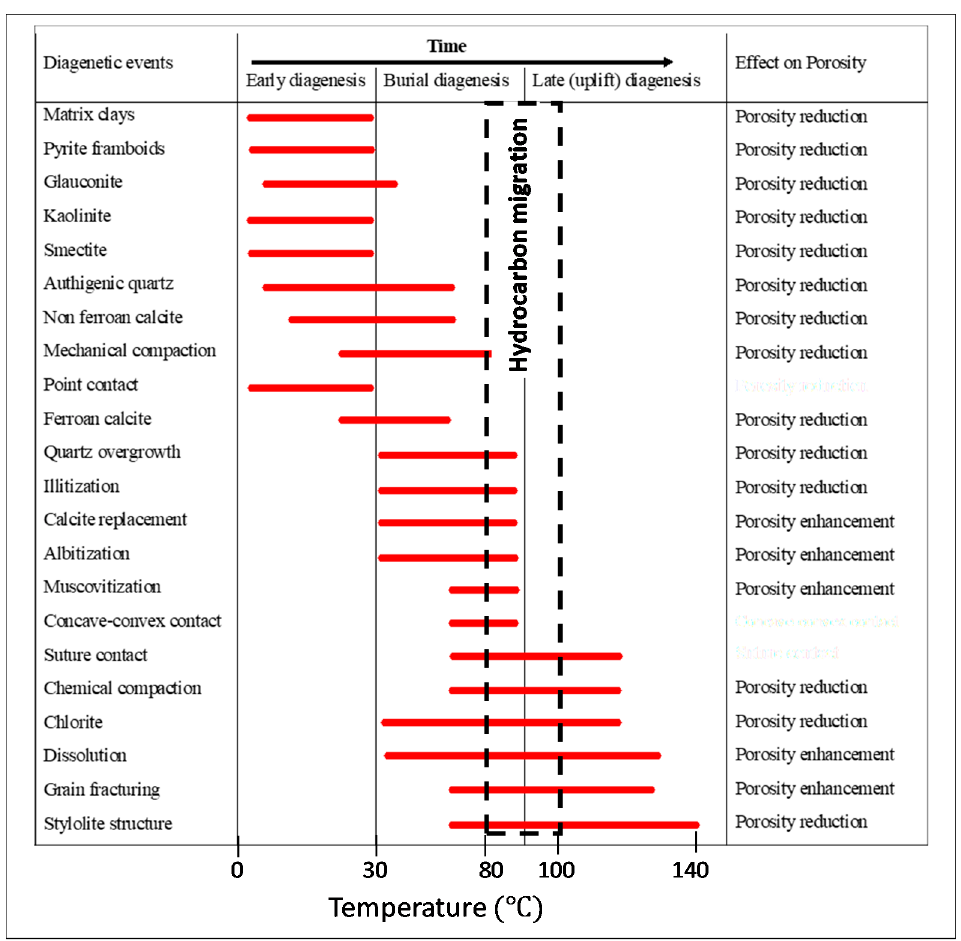
Table 9. Generalized paragenetic sequence of the Bredasdorp sandstones as established in this study.